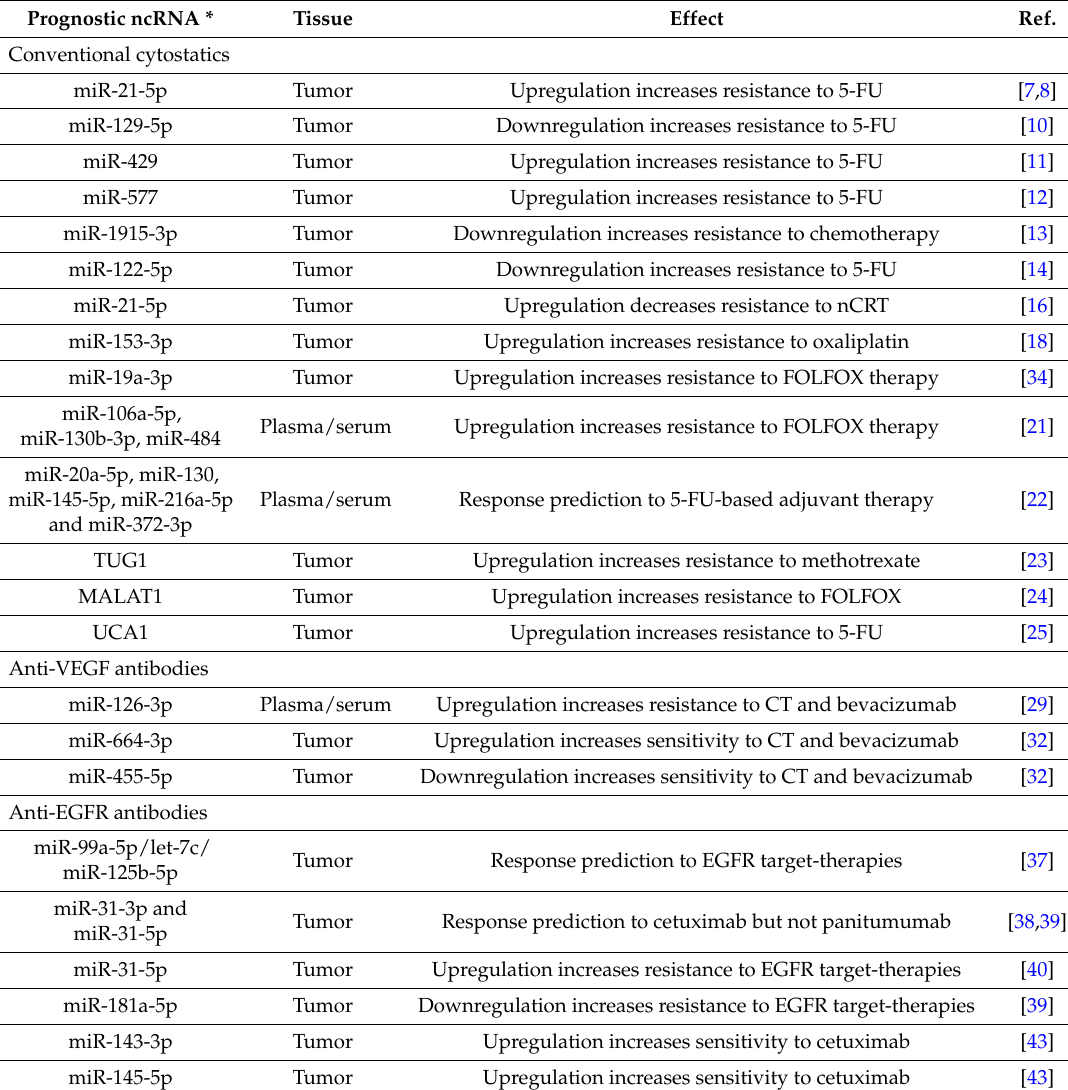
Table 1. Summary of ncRNAs that are response-to-therapy predictors in